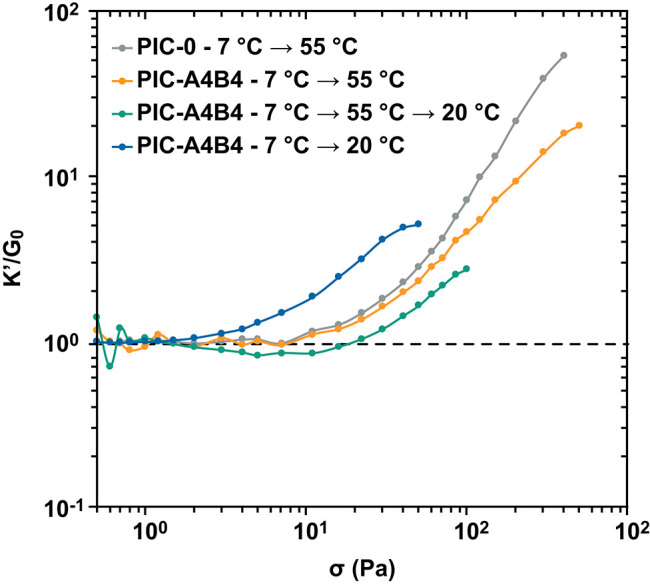
Stress-stiffening of PIC hydrogels. The PIC-A4B4 and PIC-0 samples (pre-treated with the respective temperature protocol) were subjected to a defined pre-stress σ and the normalized differential modulus K′/G0 was determined. The measurement was performed in triplicate. The additional data sets are shown in Supplementary Figure 4 and Supplementary Tables 3–6. Lines are drawn to guide the eye.